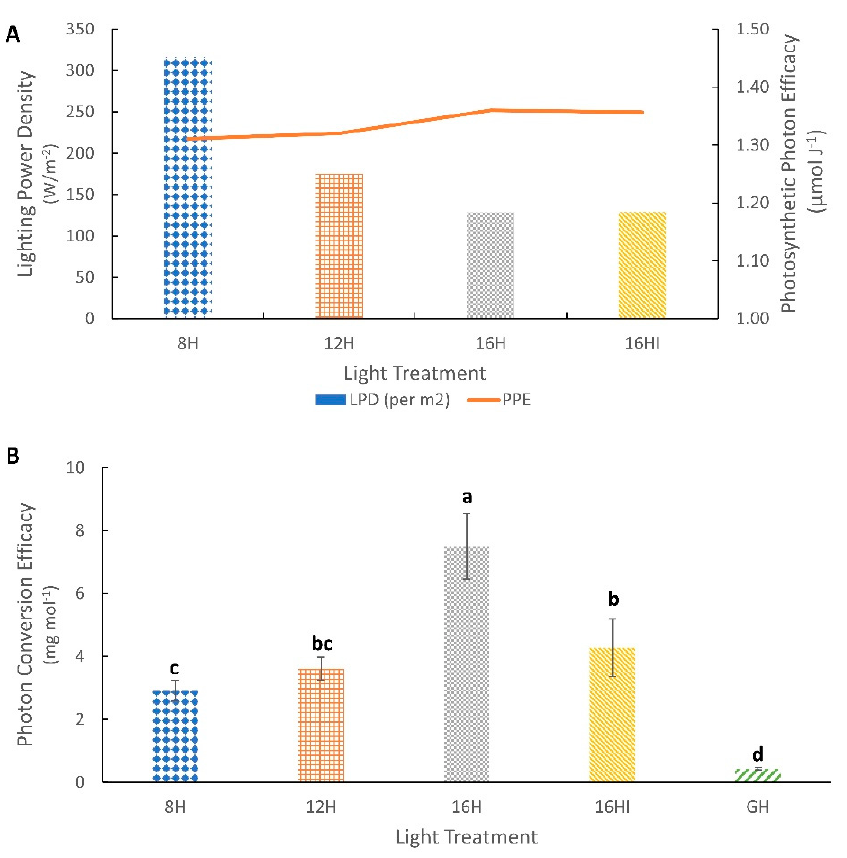
Figure 5. Photosynthetic and Photon Conversion Efficacy. ( A ) Lighting Power Density (W m − 2 ) and Photosynthetic Photon Efficacy ( µ mol J − 1 ) for different artificial light treatments. The bar charts indicate the Lighting Power Densities (LPD) for the different light treatments, while the Line chart describes the Photosynthetic Photon Efficacies (PPE) for the same light treatments. ( B ) Photon Conversion Efficacy (PCE), the total amount of ST and Reb A produced for every mol of light (mg mol − 1 ). Values represents Mean (n = 72) ± Standard Deviation. Different letters above the error bars indicate statistical significance determined by Tukey’s HSD post hoc test at p < 0.05.